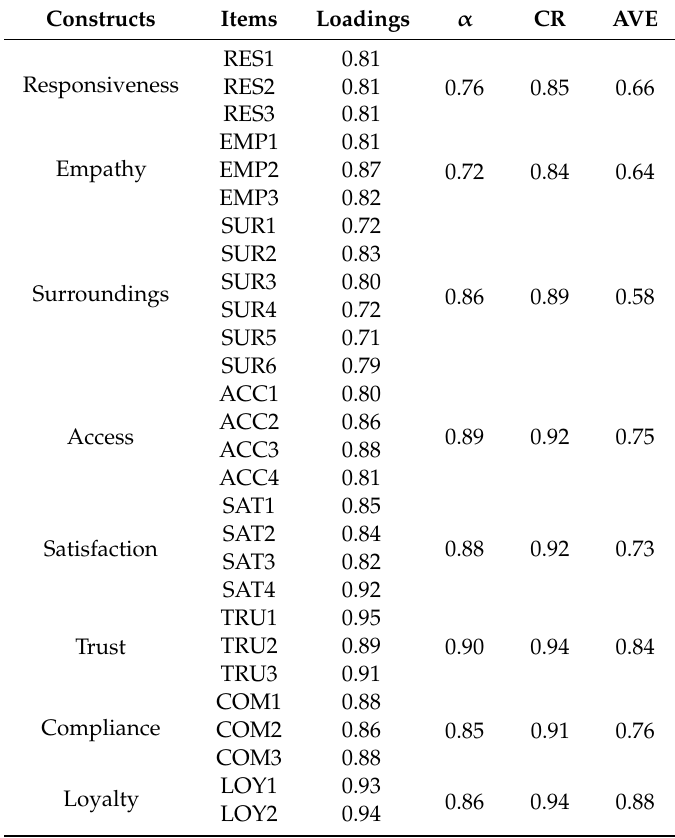
Table 3. Construct reliability and